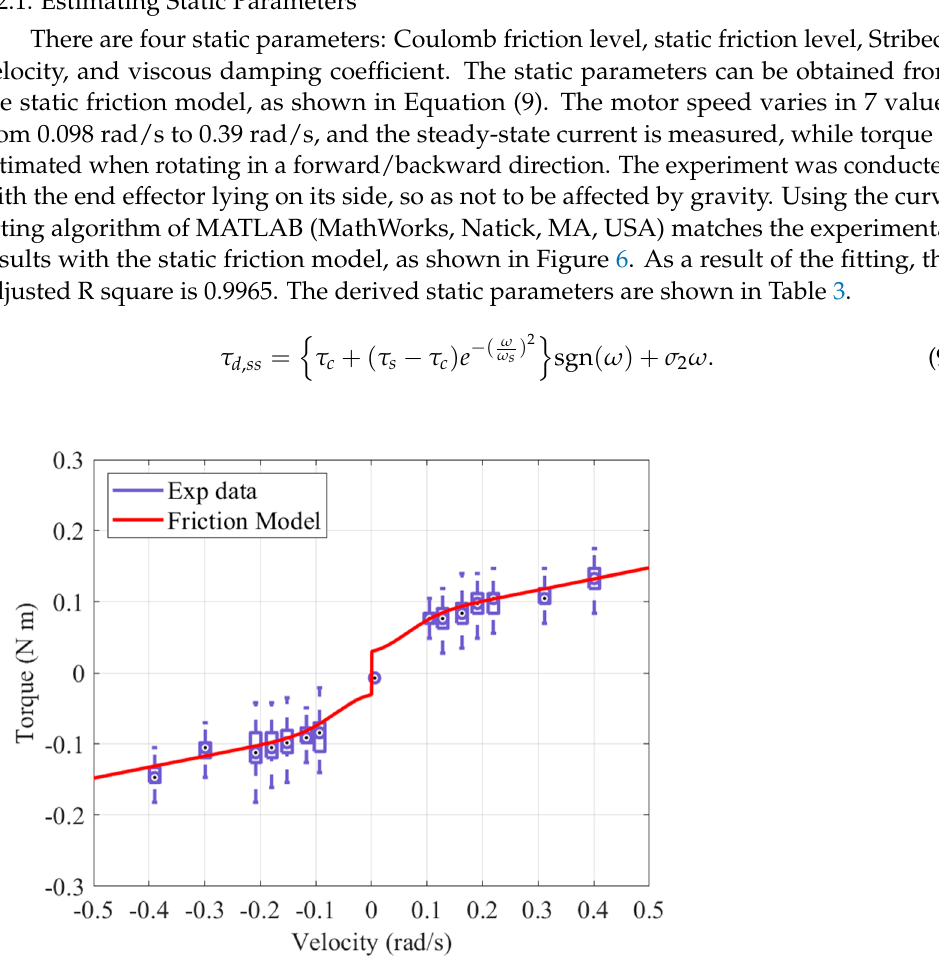
Figure 6. Stribeck curve for the static friction model. Table 3. Static parameters of the LuGre